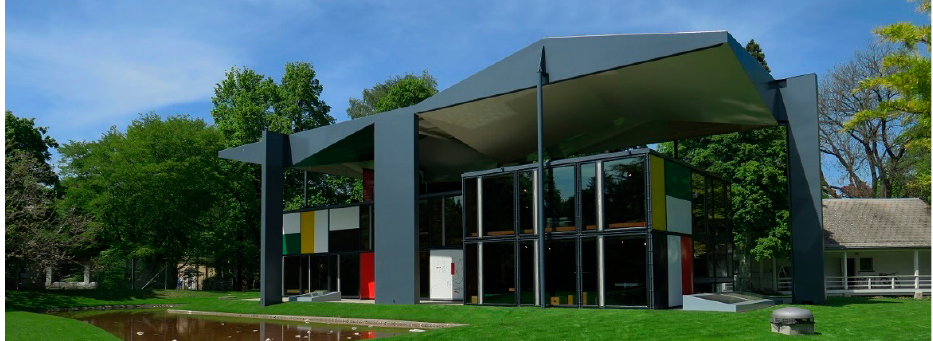
Figure 1. Le Corbusier Center, Zurich, 1961–1967 [4].